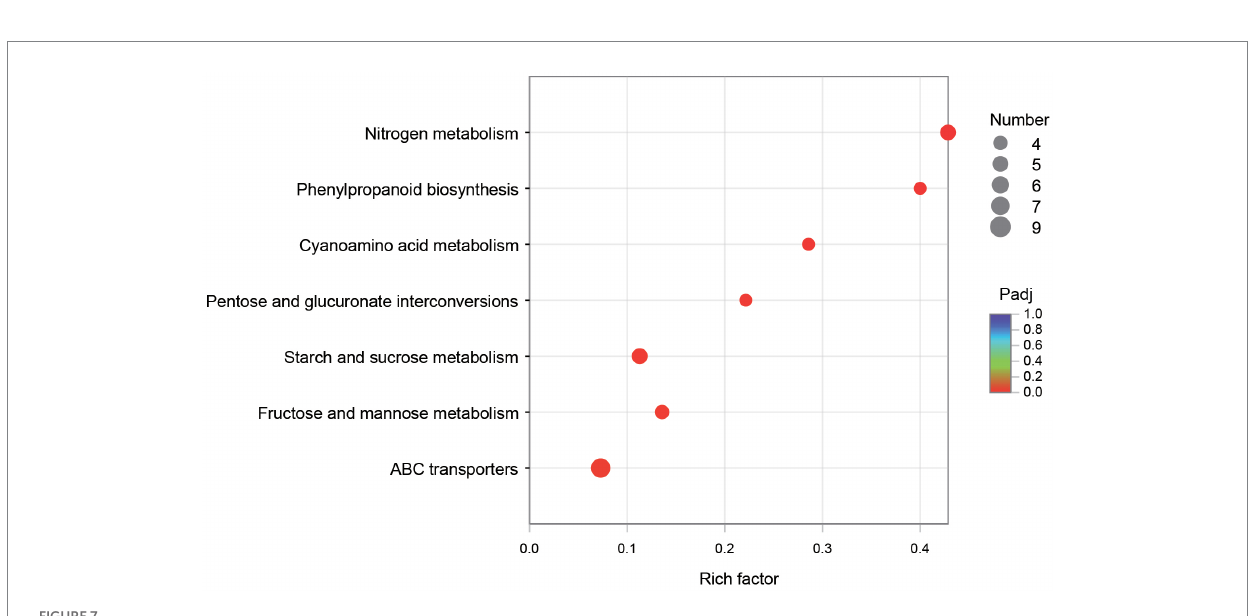
FIGURE 6 The GO annotation classification of the SDE genes.